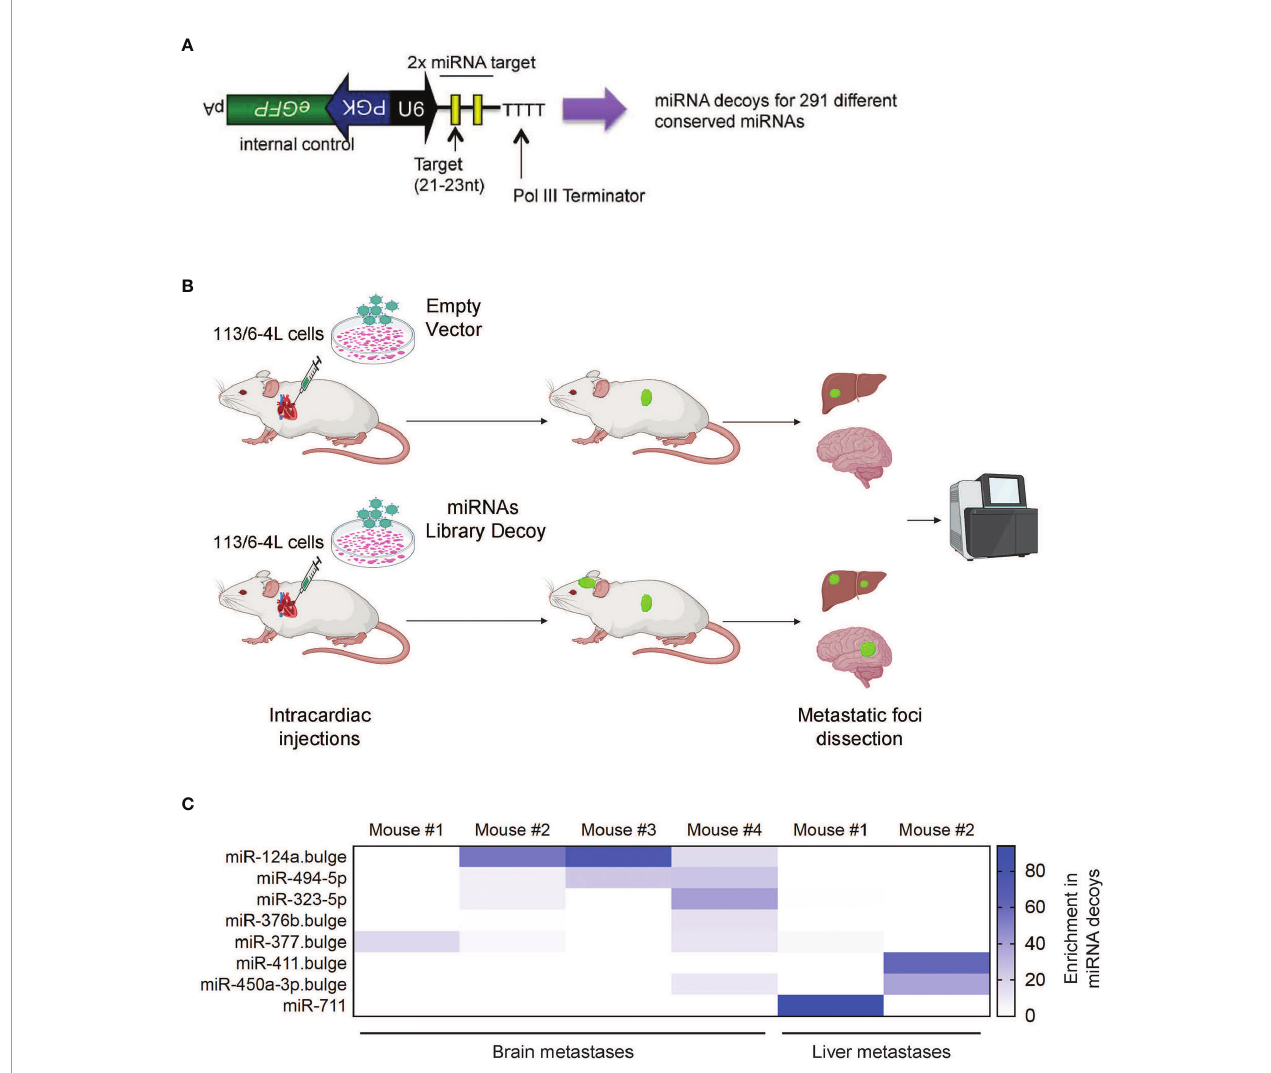
FIGURE 1 | In vivo screen of suppressors of melanoma metastasis. (A) Schematic of the lentiviral vector-based miRNA decoy vector (25). miRNA decoy target sites were cloned into a lentiviral vector downstream of the U6 promoter. This vector also encodes GFP as a reporter from a separate promoter. (B) Schematic representation of the in vivo brain metastasis screen: The 113/6-4L melanoma cells transduced with control (Empty Vector) or with a lentiviral library pool of decoys targeting 291 miRNAs (miRNAs Library Decoy) were transplanted by ultrasound-guided intracardiac injection in athymic/nude female mice (Decoy Empty, n = 6; miRNA Decoy Library, n = 12). (C) Deep sequencing of accelerated metastatic lesions revealed miR-124a decoy as enriched (% reads for a particular Decoy over total number of reads) in brain metastases from different mice. Scale shows enrichment of speci fi c miRNA decoys in the metastatic lesions